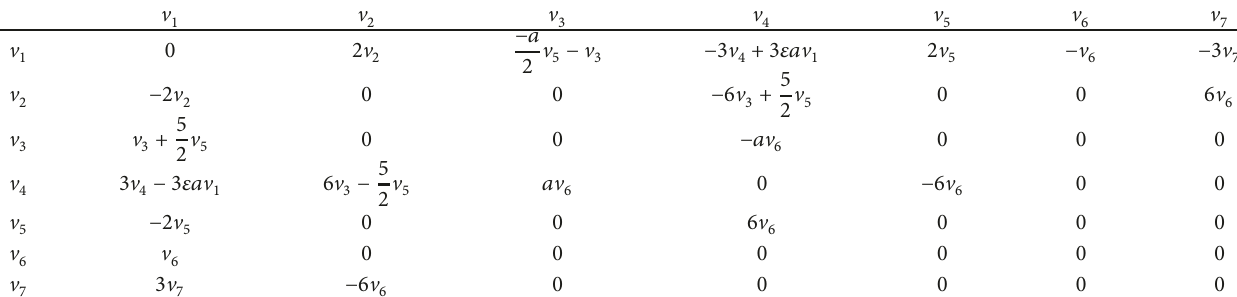
Table 2: Approximate commutators of approximate symmetry algebra of (1) ( 𝛼 = 2𝛽 , 𝑎 = 3𝛼 ).